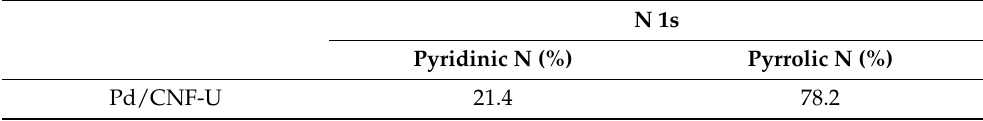
Table 5. Distribution of nitrogen-containing species on Pd/CNF-U.